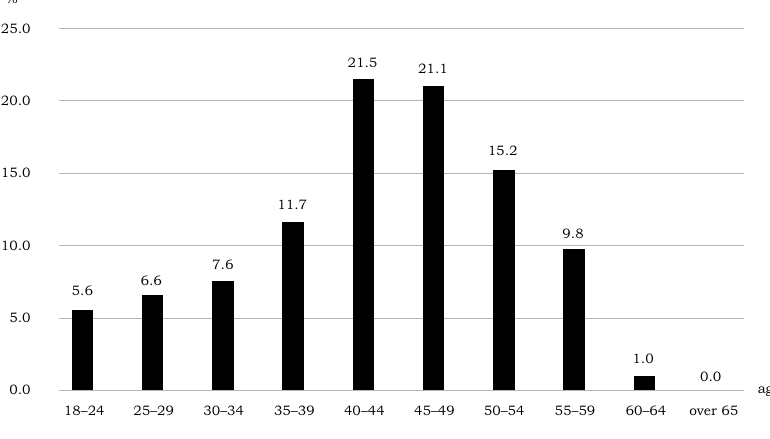
Figure 3. Age composition of regular workers Note: Based on the mean value of the answers, N =